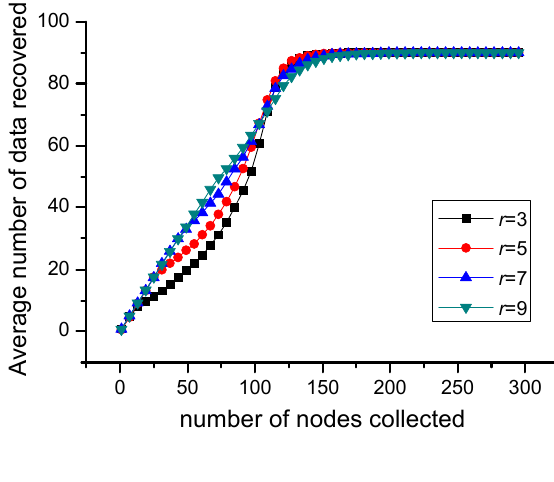
Figure 15. Data recovered in network with different communication